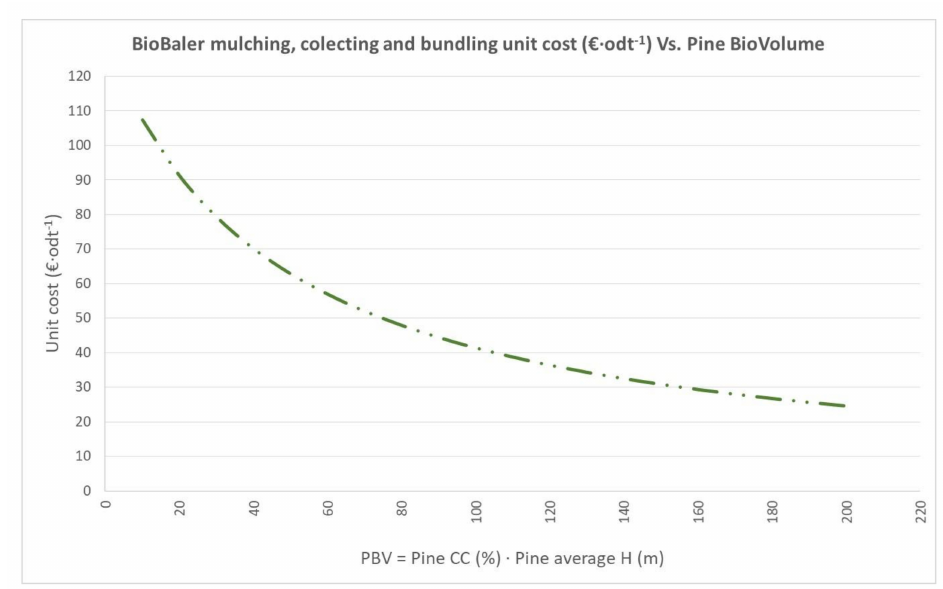
Figure 3. Relationship between Biobaler clearing and baling cost per odt and pine biovolume (canopy cover % height in